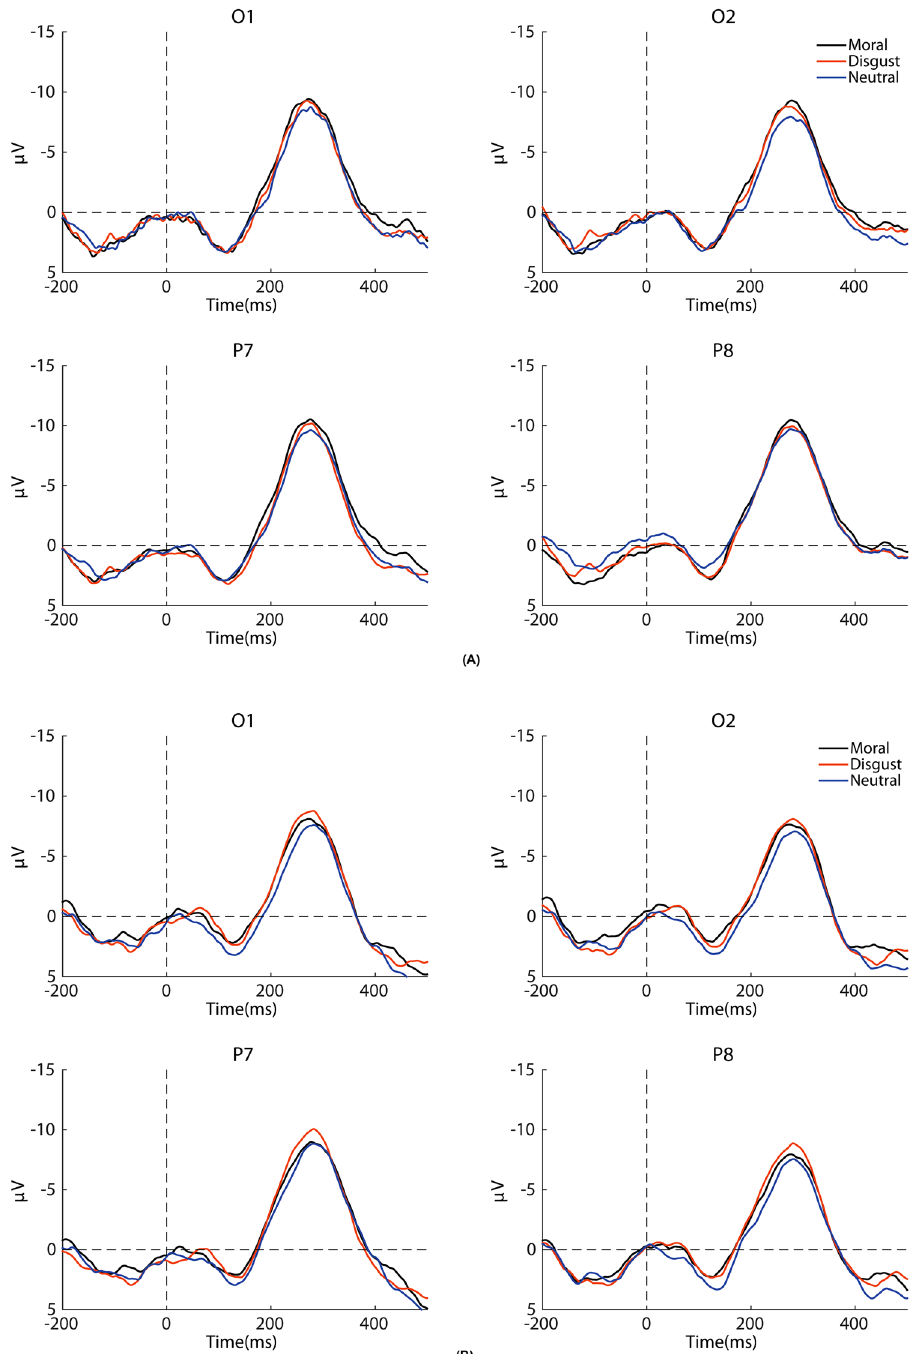
Figure 3. Grand average waveforms for the RP component at O1, O2, P7, and P8 across the three types of words for the high-sensitivity group ( A ) and the low-sensitivity group ( B